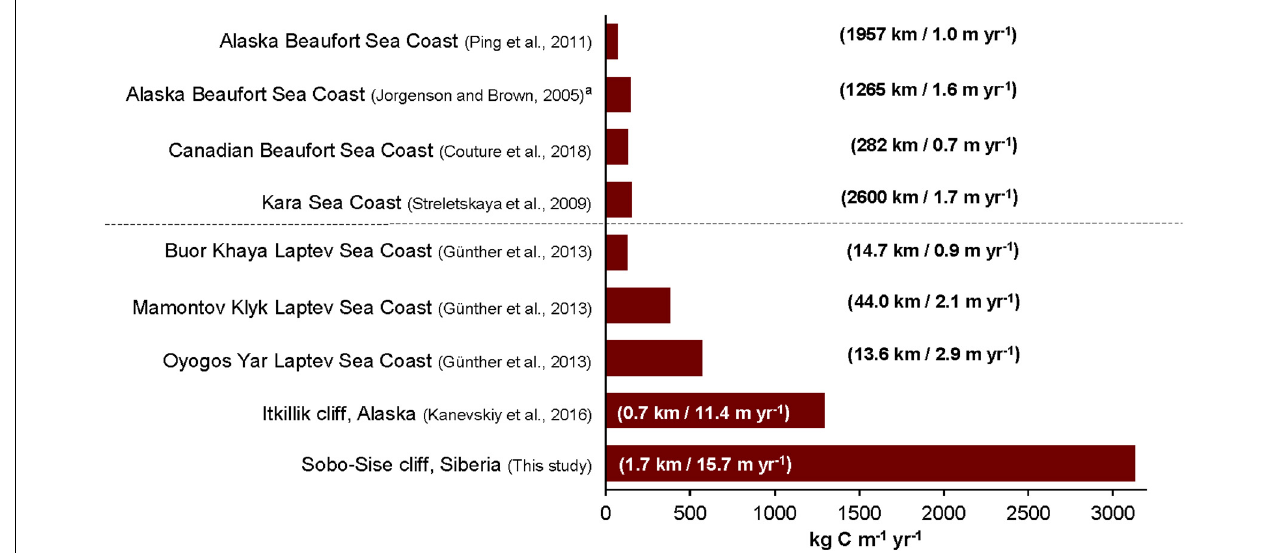
FIGURE 6 | Comparison of C fluxes in kg C m - 1 yr - 1 from studied coastal erosion sites. Numbers in brackets show the length of studied coast and the mean annual erosion for the studied coast. Studies below the dashed line focus on yedoma deposits. Only the two last studies investigate fluvial thermo-erosion, while all the other studies investigate coastal erosion processes. a In comparison to Ping et al. (2011); Jorgenson and Brown (2005) do not include delta areas along the Alaska Beaufort Sea